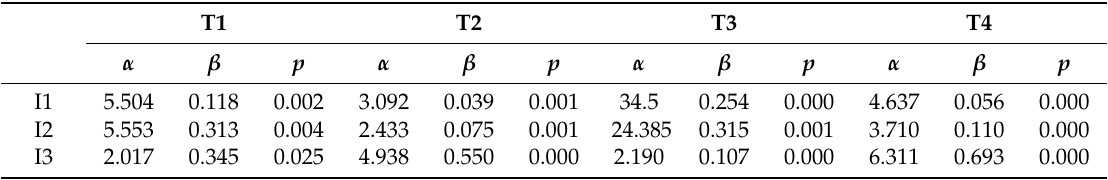
Table 1. Outcomes of logistic regression analysis for the three indicators.